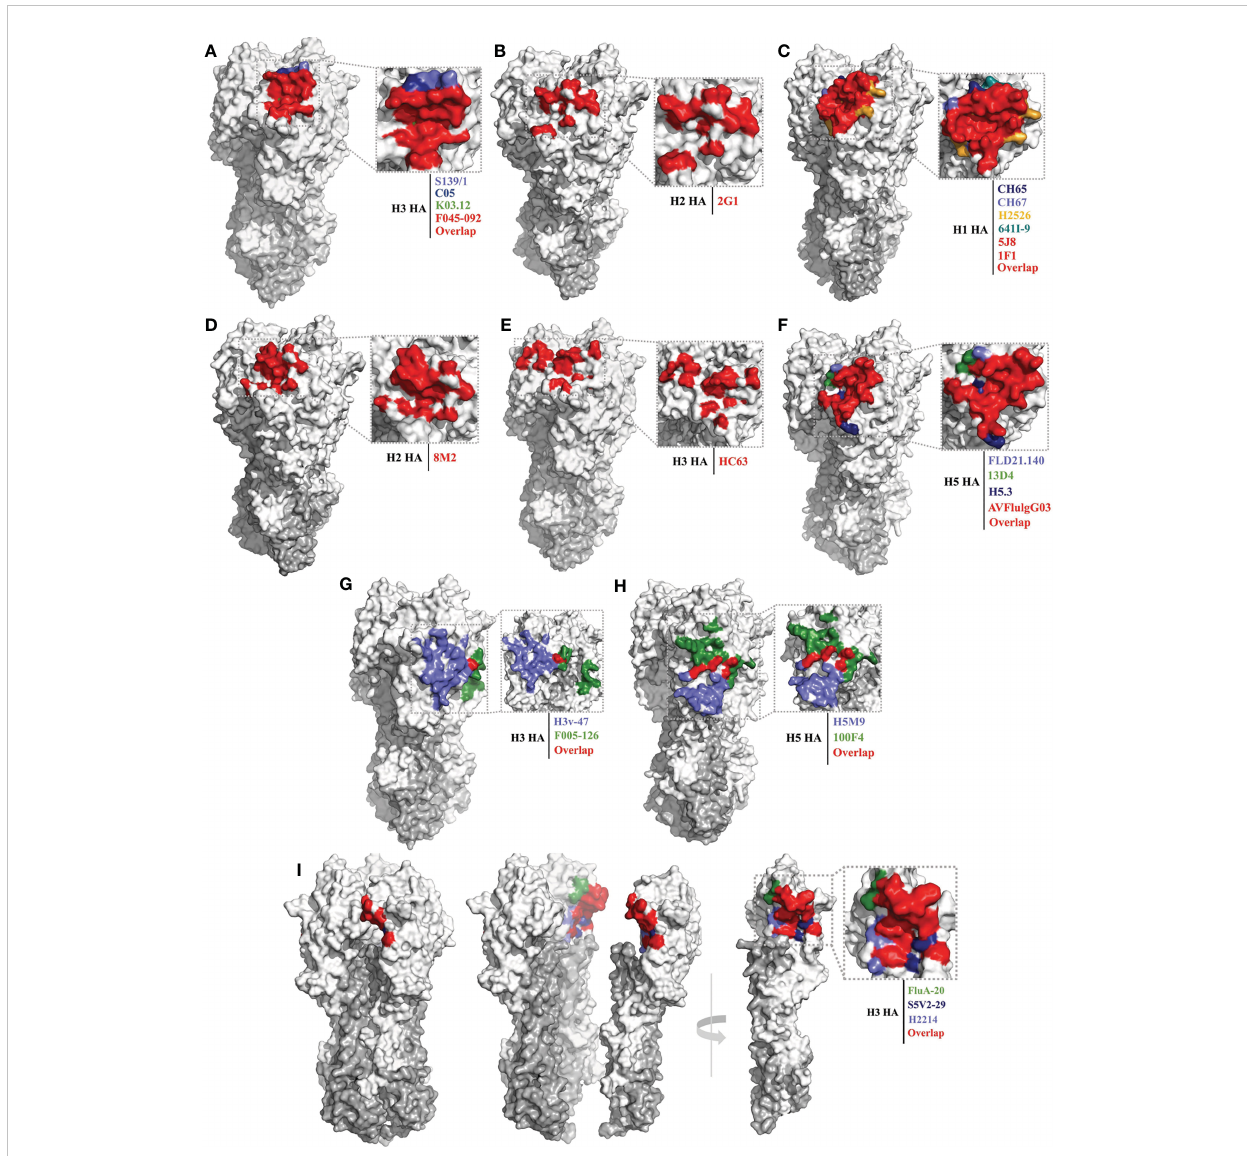
FIGURE 2 Conserved epitopes of the HA head domain. HA1 is shown in white, HA2 in gray. (A, B) are epitope footprints of cross-subtype bnAbs binding to the RBS. (A) H3 HA (PDB ID: 4FNK) as a model, the epitope of F045-092 (PDB ID: 4O58) is all overlapped shown in red, the non-overlapping residues are shown in light purple (S139/1, PDB ID:4GMS), dark blue (C05, PDB ID:4FQR), and green (K03.12, PDB ID: 5W08), respectively. (B) H2 HA (PDB ID: 4HLZ) as a model, the epitope of 2G1 (PDB ID: 4HG4). (C – F) are epitope footprints of subtype speci fi c bnAbs binding to the RBS. (C) H1 HA (PDB ID: 4M4Y) as a model, the epitopes of 5J8 (PDB ID:4M5Z) and 1F1 (PDB ID: 4GXU) are overlapped in red. The non-overlapping residues are shown in dark blue (CH65, PDB ID: 5UGY), light purple (CH67, PDB ID: 4HKX), yellow (H2526, PDB ID: 4YJZ), blue-green (641I-9, PDB ID: 4YK4), respectively. (D) H2 HA (PDB ID: 4HLZ) as a model, the epitope of 8M2 (PDB ID: 4HFU). (E) H3 HA (PDB ID: 4FNK) as a model, the epitope of HC63 (PDB ID: 1KEN). (F) H5 HA (PDB ID: 4MHH) as a model, the epitope of AVFlulgG03 (PDB ID: 5DUP) is overlapped in red. The non-overlapping residues are shown in light purple (FLD21.140, PDB ID: 6A67), green (13D4, PDB ID: 6A0Z), and dark blue (H5.3, PDB ID: 4XNM), respectively. (G, H) are epitope footprints of bnAbs binding to the VE subdomain. (G) H3 HA (PDB ID: 4FNK) as a model, non-overlapping residues are shown in light purple (H3v- 47, PDB ID: 5W42) and green (F005-126, PDB ID: 3WHE). (H) H5 HA (PDB ID: 4MHH) as a model, non-overlapping residues are shown in light purple (H5M9, PDB ID: 4MHH) and green (100F4, PDB ID:5DUR). (I) Epitope footprint of bnAbs binding to the occluded epitope region of the HA monomers interface. H3 HA (PDB ID: 2VIU) as a model, non-overlapping residues are shown in green (FluA20, PDB ID: 6OCB), dark blue (S5V2-29, PDB ID:6E4X), and light purple (H2214, PDB ID: 6E56),